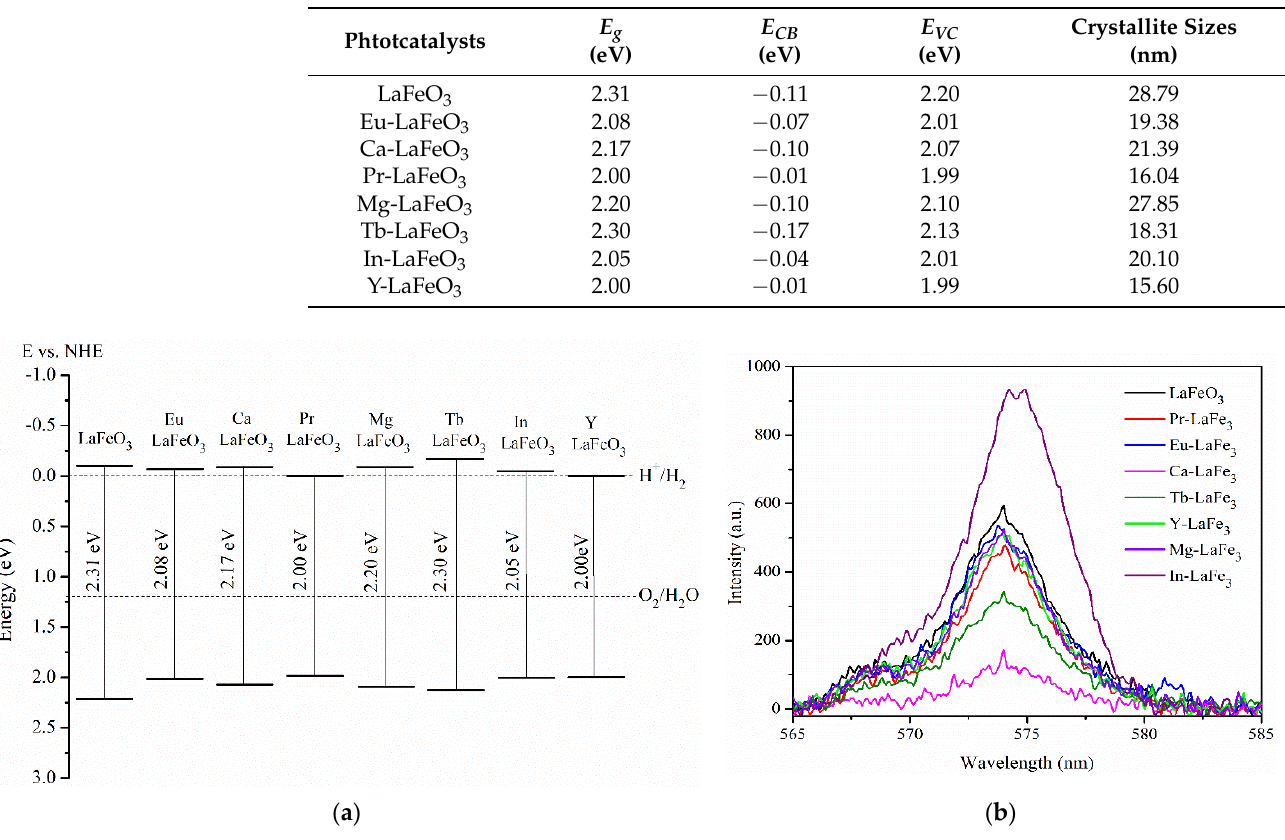
Figure 2. ( a ) Band structures and ( b ) photoluminescence spectra of different metal doped LaFeO 3 and undoped LaFeO 3 .